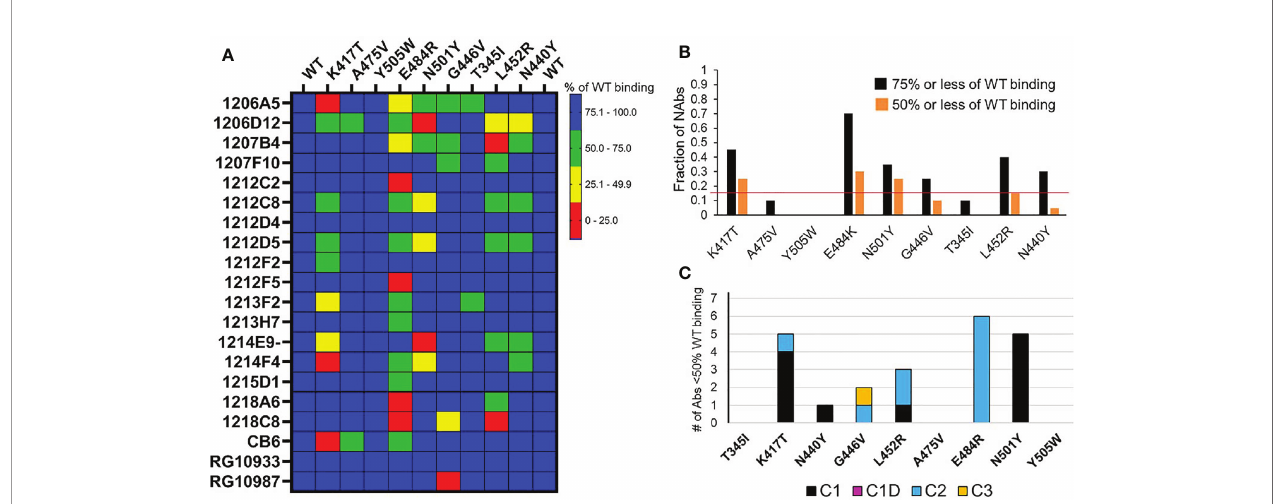
FIGURE 5 | NAb binding to RBD variants. (A) SARS-CoV-2 RBD variants were injected over NAbs captured on a biacore chip and their binding levels measured and normalized to the binding response to a reference (WT) Wuhan-1 RBD. Two WT RBD binding experiments were performed at the beginning and end of the experiment to validate the reproducibility of the assay. NAb binding is presented in the matrix as % of WT binding. (B) Global summary of NAb binding to SARS- CoV-2 RBD variants. Black bars show the fraction of NAbs that exhibit red, yellow, or green levels of binding as shown in (A) . Orange bars represent the fraction of NAbs that exhibit red and yellow binding, as shown in (A) . The horizontal red line highlights the RBD variants (K417T, E484K, and N501Y) that disrupt the binding of the largest number of NAbs. (C) Sensitivity of NAb classes to the different RBD variants. The number of NAbs that display less than 50% of WT binding in (A) (red and yellow boxes) were counted (y axis) and plotted according to their NAb classi fi cation ( Table 1